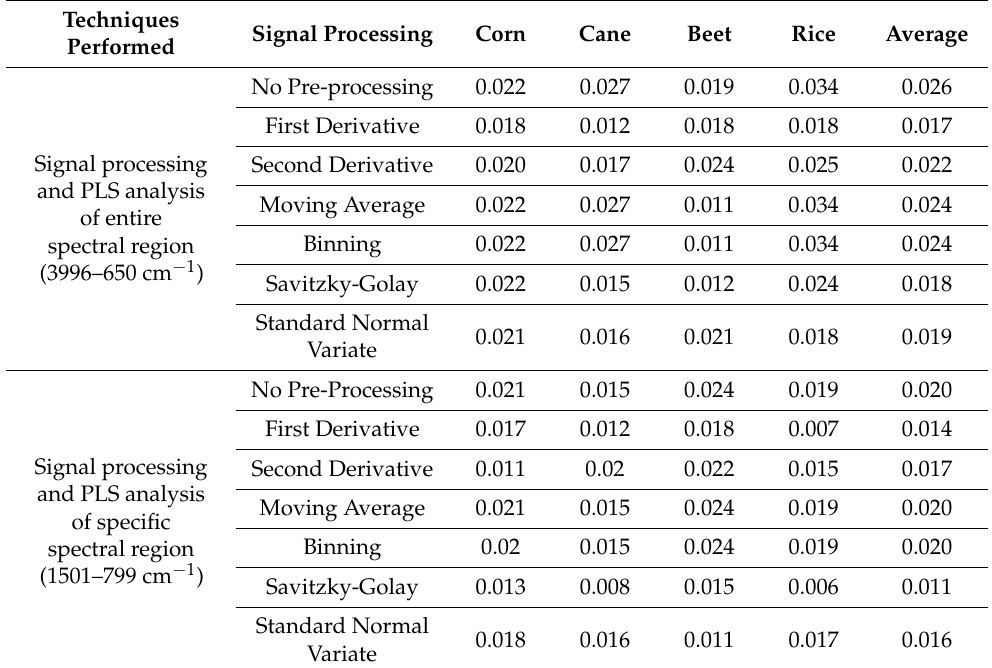
Table 3. Root mean square error of prediction values for the Box-Behnken testing set (n = 32) showing the extent of predictability of the model (PLS = partial least